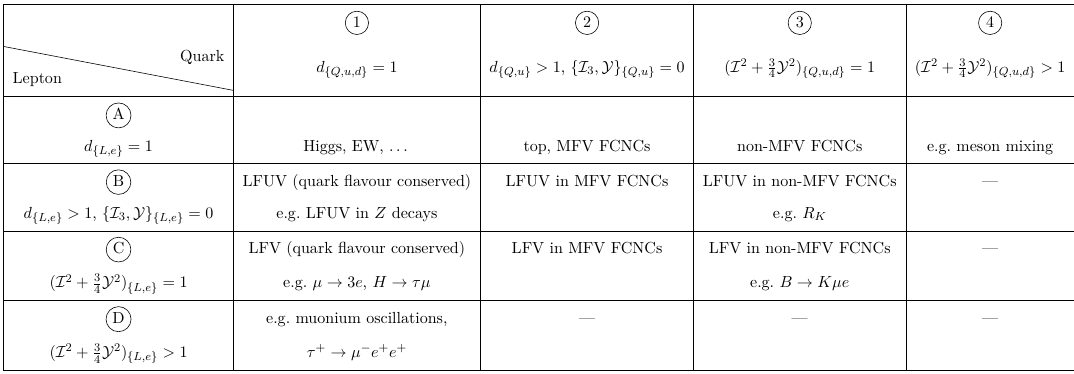
Table 1 . Coarse overview of phenomenology generated by operators whose Wilson coefficients have different flavour charges. The rows (labelled by circled letters) give four different scenarios for leptonic flavour charges. We have grouped together L and e here, but for each case we assume that only one carries the flavour charges given. Similar logic applies to the columns (labelled by circled numbers), which list charges for Q , u and d (note that the scenarios listed are not exhaustive). Within the table, we give examples of phenomenology that can be generated by operators carrying the specified charges, including lepton flavour violation (LFV), lepton flavour universality violation (LFUV) and flavour changing neutral currents